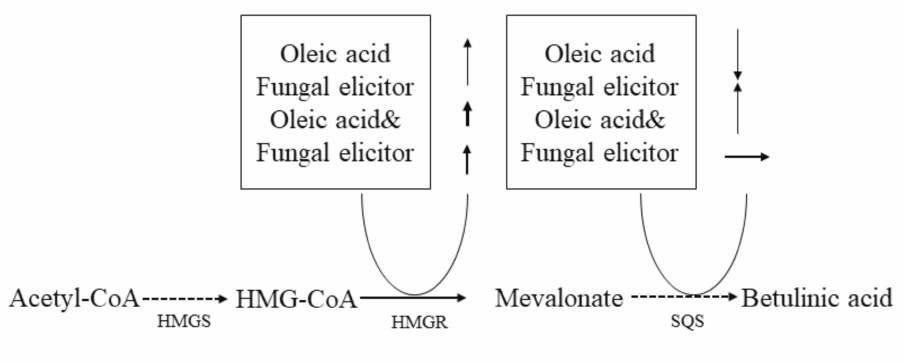
Figure 7. The postulated regulation way of small molecules on BA